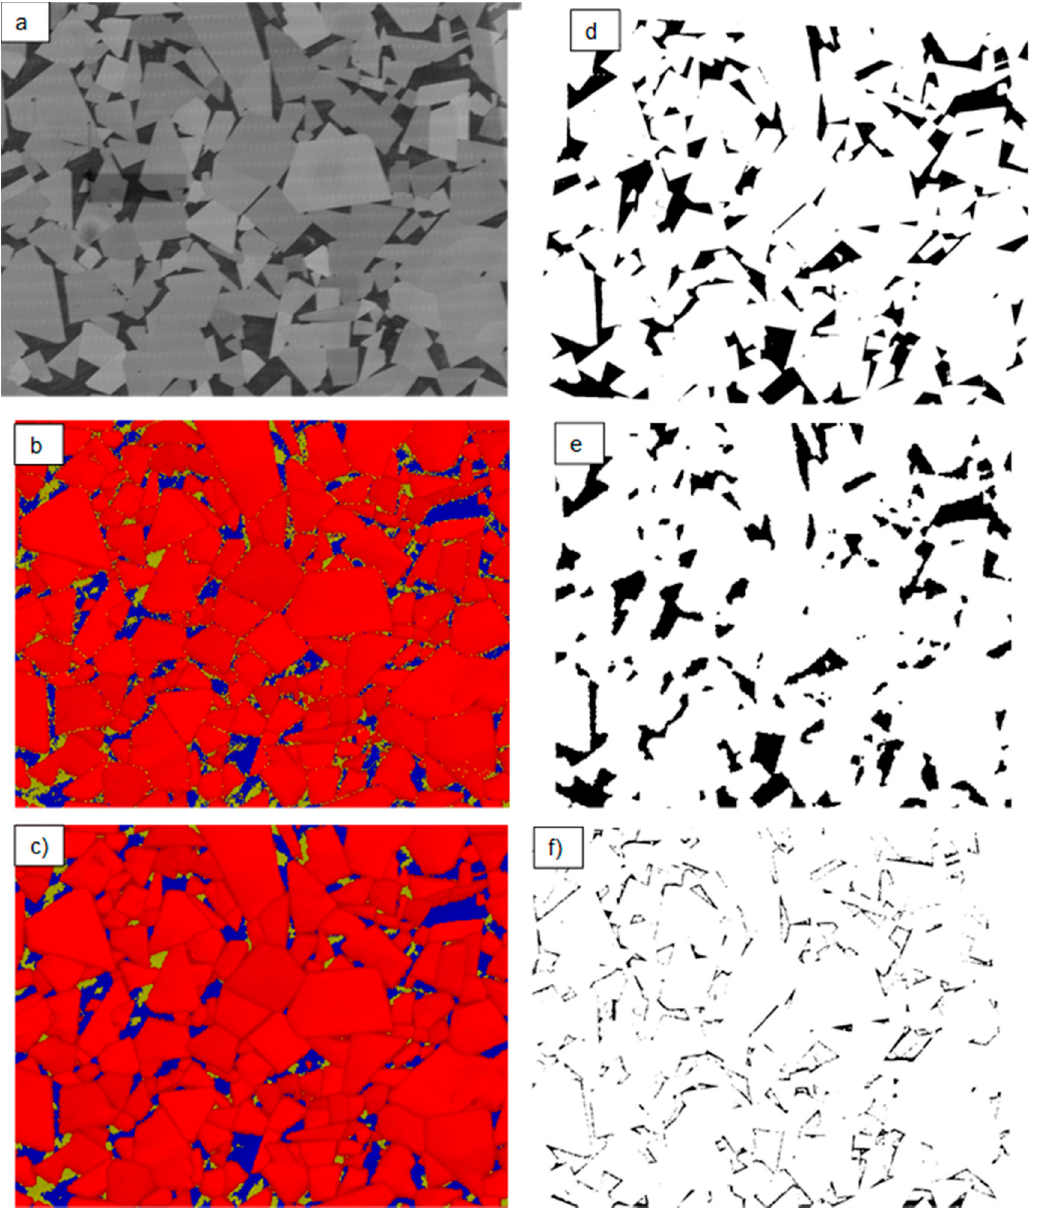
Figure 5. Comparison of a backscattered Scanning Electron Microscope (SEM) image ( a ), with raw EBSD map ( b ), and EBSD map after reindexing of poorly indexed pixels ( c ), to show the effect of lower resolution of EBSD map on the identification of Co. The Co regions are shown separated by thresholding (a) to give ( d ), and (c) to give ( e ). The Co regions not fully mapped by EBSD can thus be seen as the black areas in ( f ), obtained by subtracting (e) from (d).